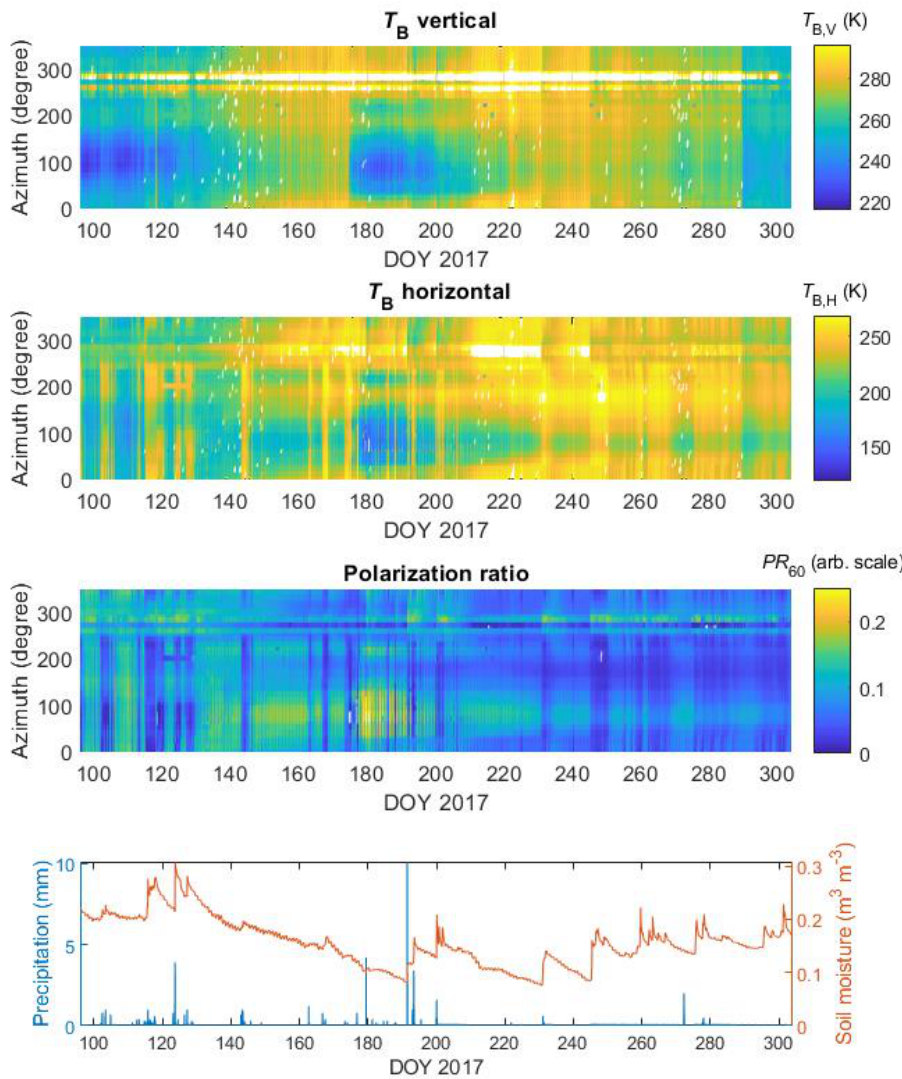
Figure 5. Hovmöller diagrams of brightness temperatures from ELBARA III and the time-series of the SM and precipitation from the agrometeorological station for 2017 (elevation angle 60 ◦ ). The white color is related to brightness temperatures artificially increased by radio frequency interference (RFI) or other factors.